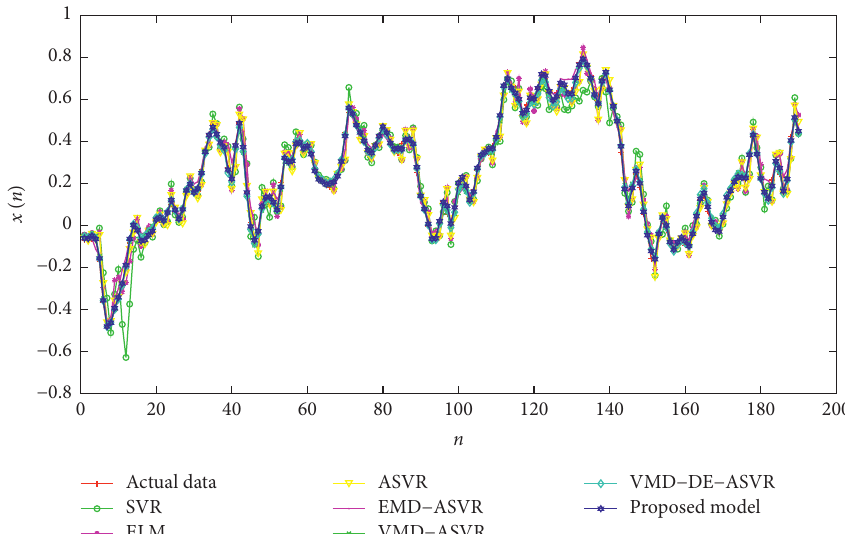
Figure 14: Prediction results for each model of data set A.